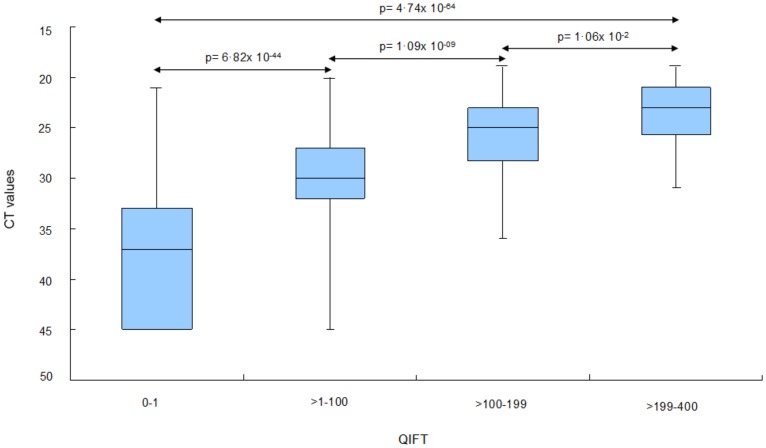
Binning analysis: Estimation of CT, median values based on categorized QIFT readouts.The following QIFT categories were used: “Negative QIFT”: 0 to 1 (n = 333). “Low QIFT”: >1 to 100 (n = 254). “Moderate QIFT”: >100 to 199 (n = 56). “High QIFT”: >199 (n = 26).